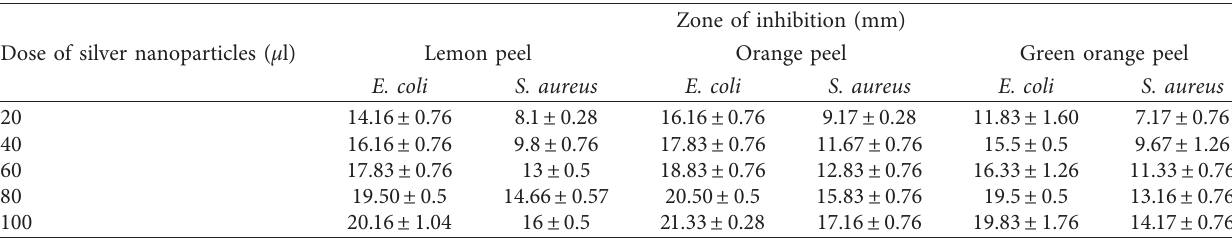
Figure 6: Antibacterial activity of silver nanoparticles synthesised using (a) lemon peel, (b) orange peel, and (c) green orange peel extract against Staphylococcus aureus . Table 1: Effect of silver nanoparticles on the growth of bacterial species.